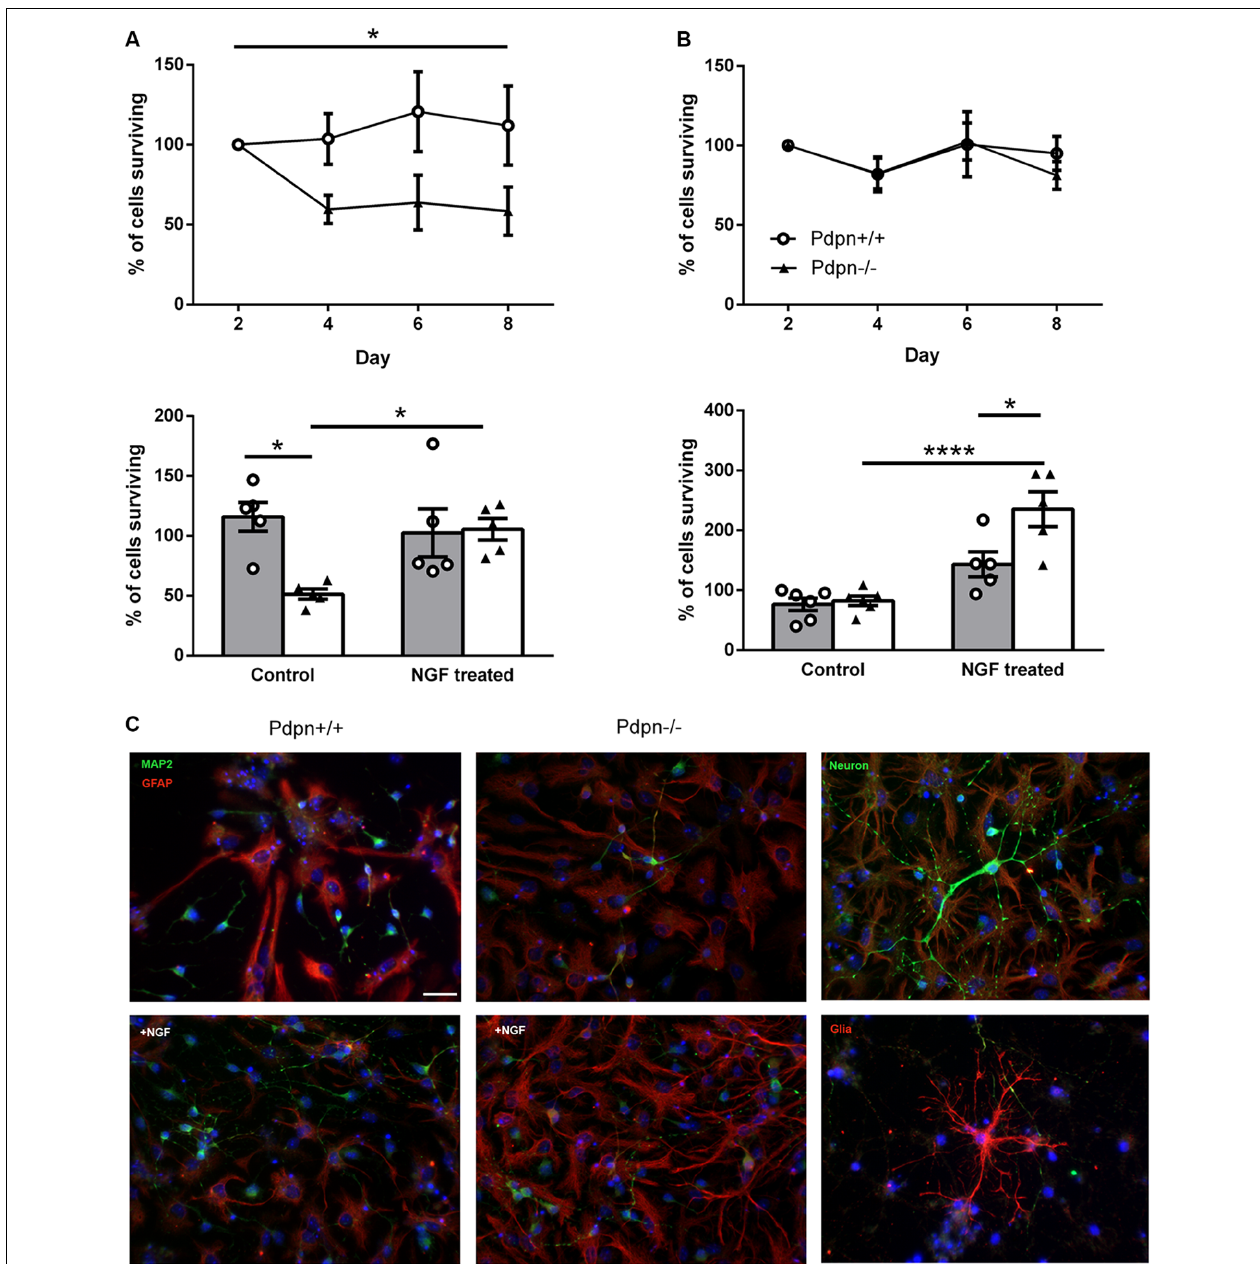
FIGURE 4 | Lack of Podoplanin selectively decreases the survival of neuronal cells that are rescued by NGF treatment. Percentage of (A) neuronal and (B) glial cells derived from Pdpn + / + and Pdpn − / − neurospheres surviving during 8 days (upper panels), showed a significant main effect of the genotype on number of surviving neurons ( ∗ P = 0.02, F ( 1,10 ) = 8.69, n = 6) but not on the number of glial cells ( P = 0.8, F ( 1,8 ) = 0.07, n = 5). No significant effects of time were observed on a number of neuronal or glial cells. Percentage of (A) neuronal and (B) glial cells derived from Pdpn + / + and Pdpn − / − neurospheres surviving after 4 days of NGF treatment, lower panels. In neuronal cells two-way ANOVA showed no significant effect of treatment ( P = 0.2, F ( 1,16 ) = 2.556, n = 6) but a significant effect of genotype ( ∗ P = 0.03, F ( 1,16 ) = 5.84, n = 6) and a significant interaction between treatment and genotype ( ∗ P = 0.02, F ( 1,16 ) = 7.07). Post hoc analysis showed a significant difference between Pdpn + / + and Pdpn − / − without treatment ( ∗ P = 0.02) and between Pdpn − / − with and without NGF treatment ( ∗ P = 0.059), as represented with asterisk on the graph. Analysis of glial cells showed a strong main significant effect of treatment ( ∗∗∗∗ P < 0.0001, F ( 1,18 ) = 38.73, n = 5), significant main effect of the genotype ( ∗ P = 0.02, F ( 1,18 ) = 7.695, n = 5) and a significant interaction between two factors ( ∗ P = 0.03, F ( 1,18 ) = 5.942, n = 5). Post hoc analysis showed a significant difference between Pdpn − / − with and without NGF treatment ( ∗∗∗∗ P < 0.0001) and between Pdpn + / + and Pdpn − / − when treated with NGF ( ∗ P = 0.02), as represented with an asterisk on the graph. (C) Representative images of differentiated neurospheres immunolabeled with neuronal (MAP2) and glial (GFAP) markers (left and central pictures). In the right, upper and lower pictures, comprise representative images of immuno-based identified neurons (upper) and glial (lower) cells. Data are displayed as mean ±